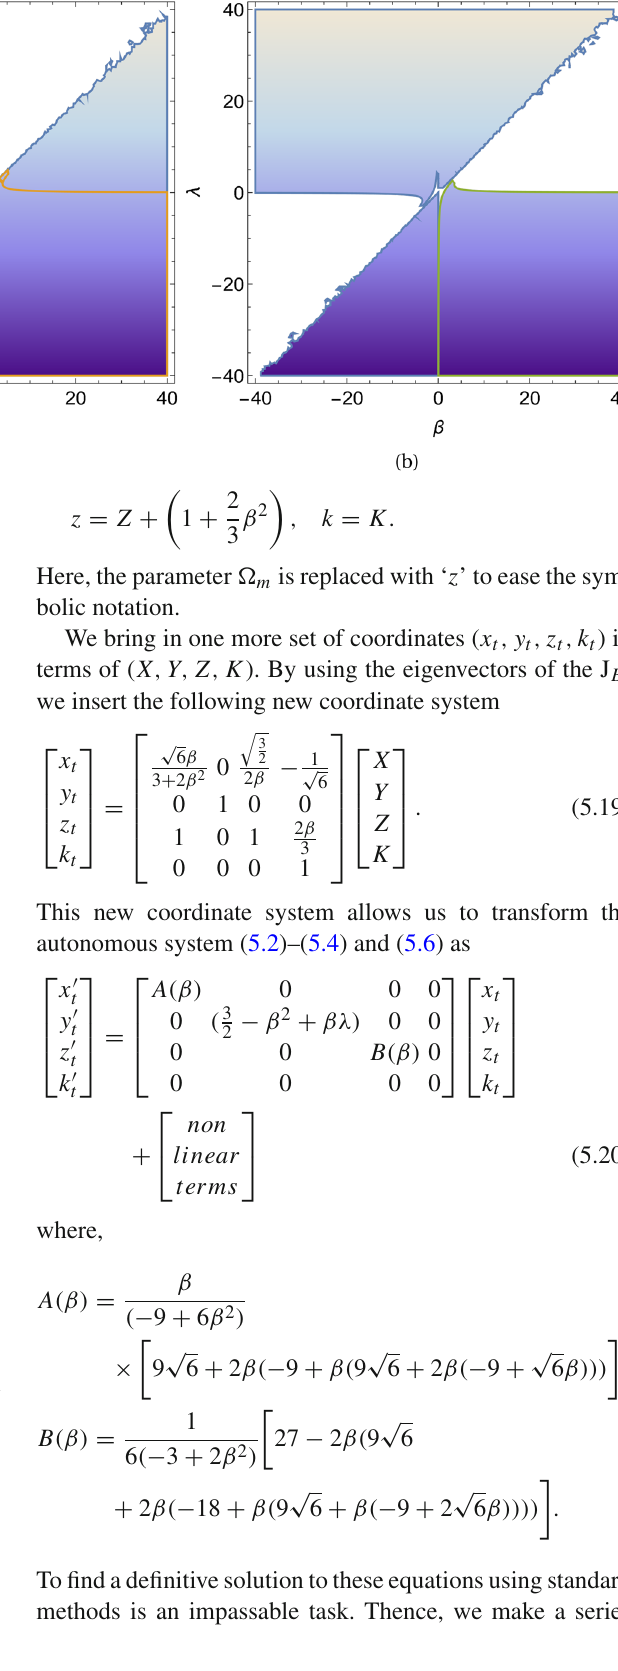
Fig. 1 The allowed range of parameter [ β,λ ] space in